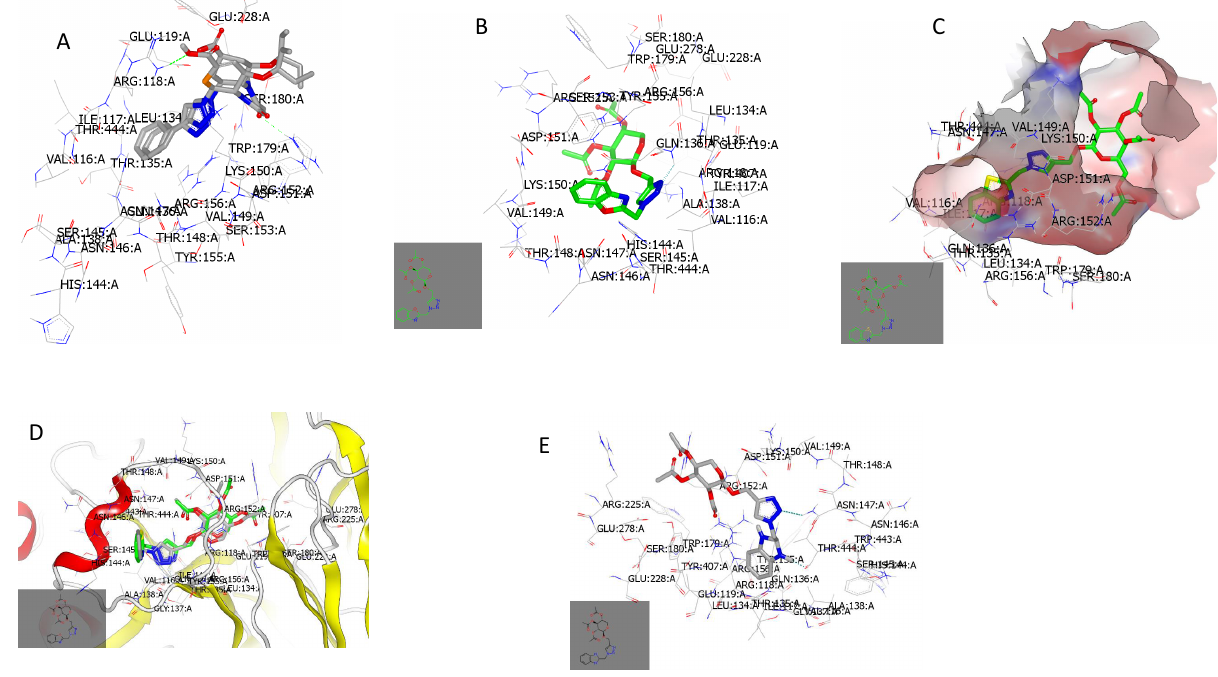
Figure 12. Visual representation of the docked compounds with neuraminidase (PDB ID: 7e6q). ( A ) The docked ligand (grey) overlay its co-crystalized complex (green); ( B ) Compound 9b forms two HBs through the nitrogen atoms of its triazole moiety; ( C ) Compound 8c displays a hydrophobic– hydrophobic interaction; ( D ) Compound 9c (grey) completely overlays its structural isomer (green); ( E ) Compound 9a shows a strong HB with Asn:147A and